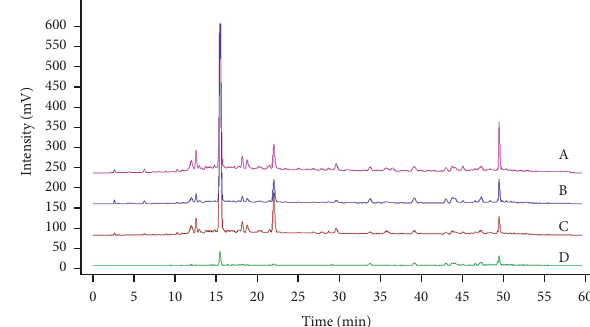
Figure 5: Effect of different detection wavelengths on chromatogram (S38 sample: A for 245nm, B for 265nm, C for 280nm, D for